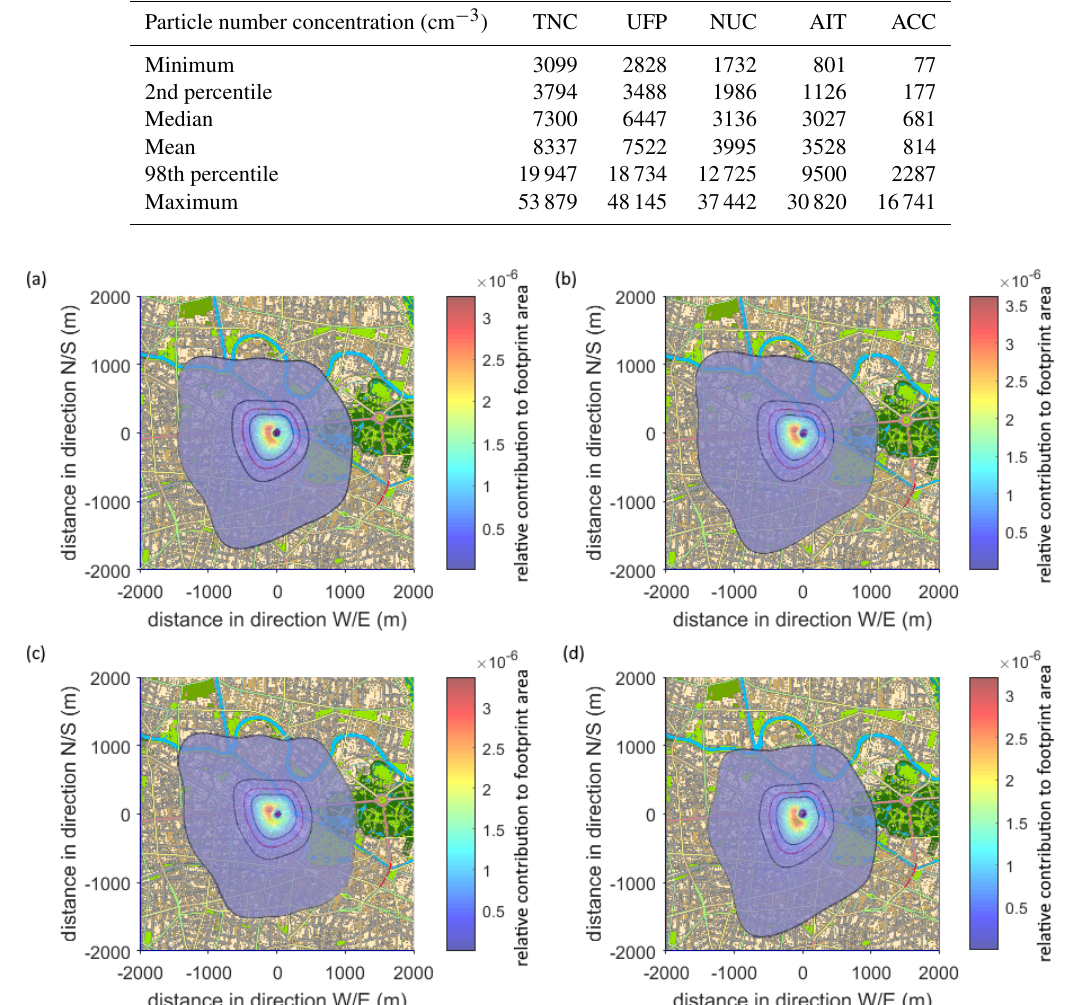
Figure 4. Footprint climatology of (a) the entire 3-year period, (b) the first year, (c) the second year, and (d) the third year. Flux footprints were calculated for a 4km × 4km area (4m spatial resolution). For reasons of clarity only the 40%, 50% (purple), 60%, and 80% contour lines are shown (footprint model: Kljun et al., 2015; map data sources: Geoportal Berlin, 2014 (modified), 2021; Umweltatlas Berlin,